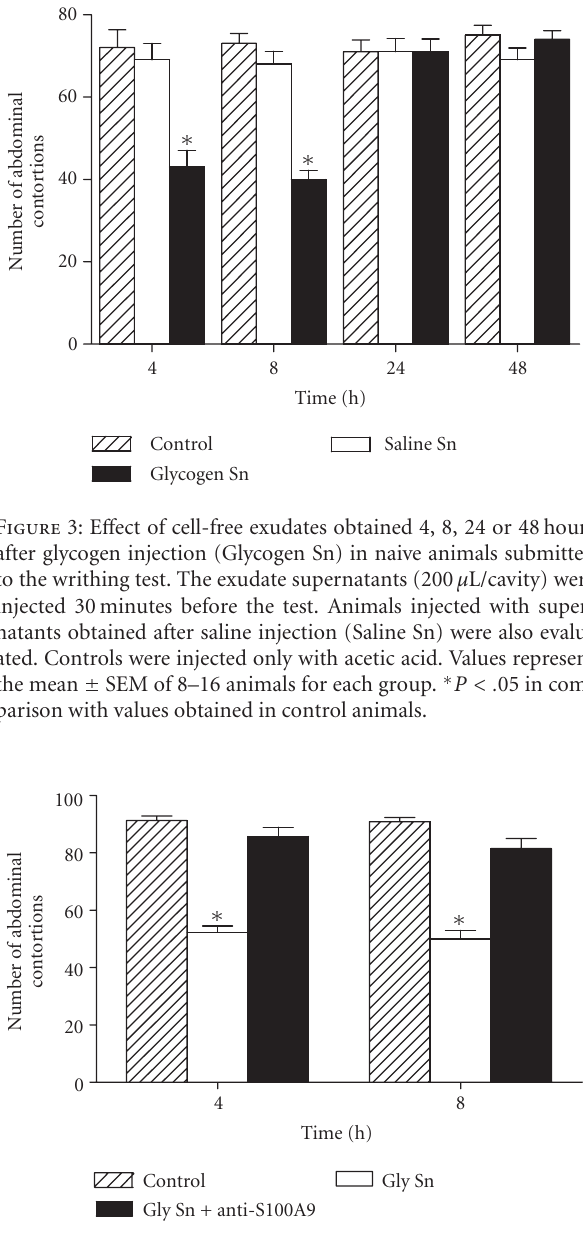
Figure 4: E ff ect of adsorption of S100A9 of cell-free exudates ob- tained 4 or 8hours after glycogen injection (Gly Sn + anti-S100A9) in naive animals submitted to the writhing test. The exudate su- pernatants (200 μ L/cavity) were injected 30 minutes before the test. Animals injected with exudate supernatants not treated with mAb anti-S100A9 (Gly Sn) were also evaluated. Controls were injected SEM of 8–16 an- only with acetic acid. Values represent the mean (cid:0) imals for each group. (cid:0) P < . 05 in comparison with values obtained in control